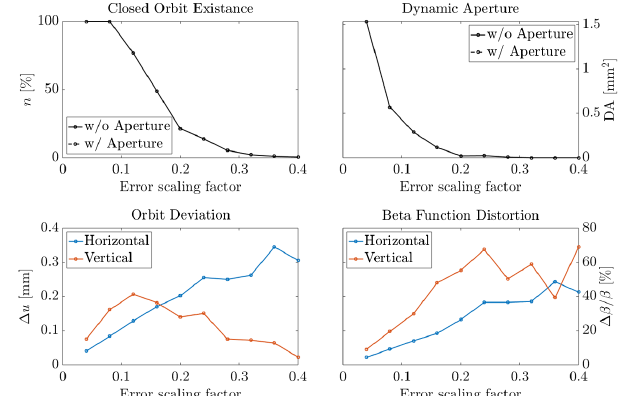
FIG. 4. Lattice properties before correction for different scaling factors of the nominal error set. The plots are the fraction of lattice realizations at which the closed orbit exists (upper left), the rms dynamic aperture (upper right), and the rms closed orbit deviation (lower left) and beta beat (lower right). The calculations in the top images were done with (dashed) and without (solid) physical apertures, but the results are indistinguishable. Note that beta beat and orbit error are only calculated for the cases in which the closed orbit